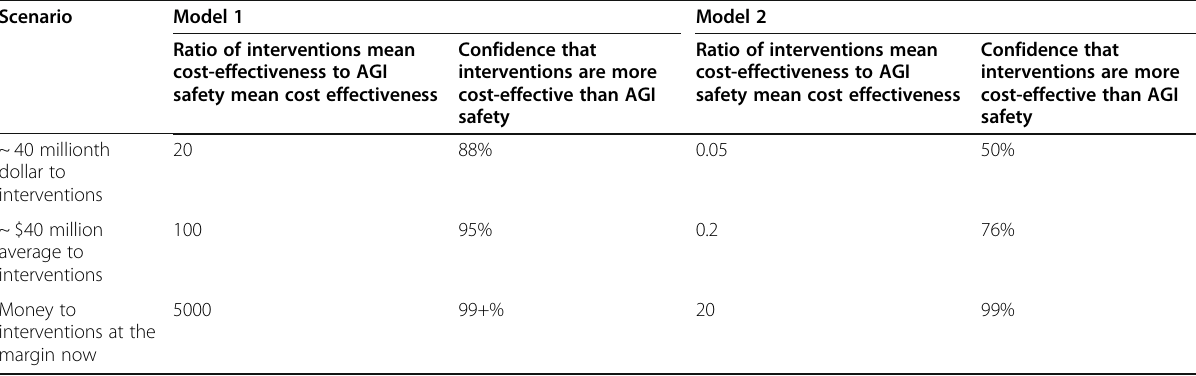
Table 3 Key cost-effectiveness outputs of losing industry interventions Scenario Model 1 Model